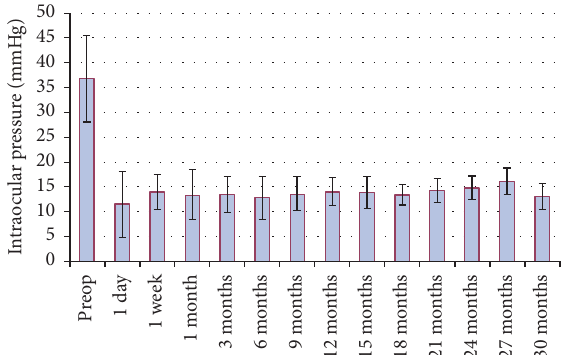
Figure1:Themeanintraocularpressureafterdeepsclerectomywith T-flux.